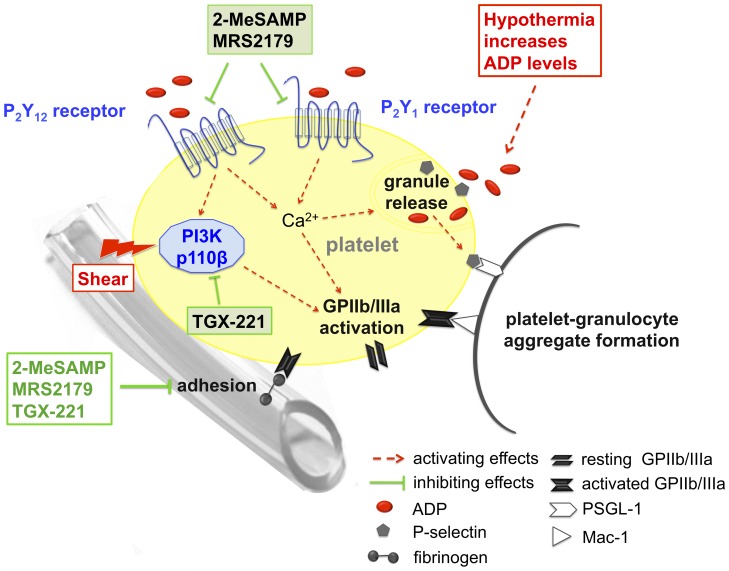
Overview of a pharmacological strategy for platelet protection during hypothermic ECC employing P2Y12 and P2Y1 receptor blockers as well as a PI3K p110β inhibitor.